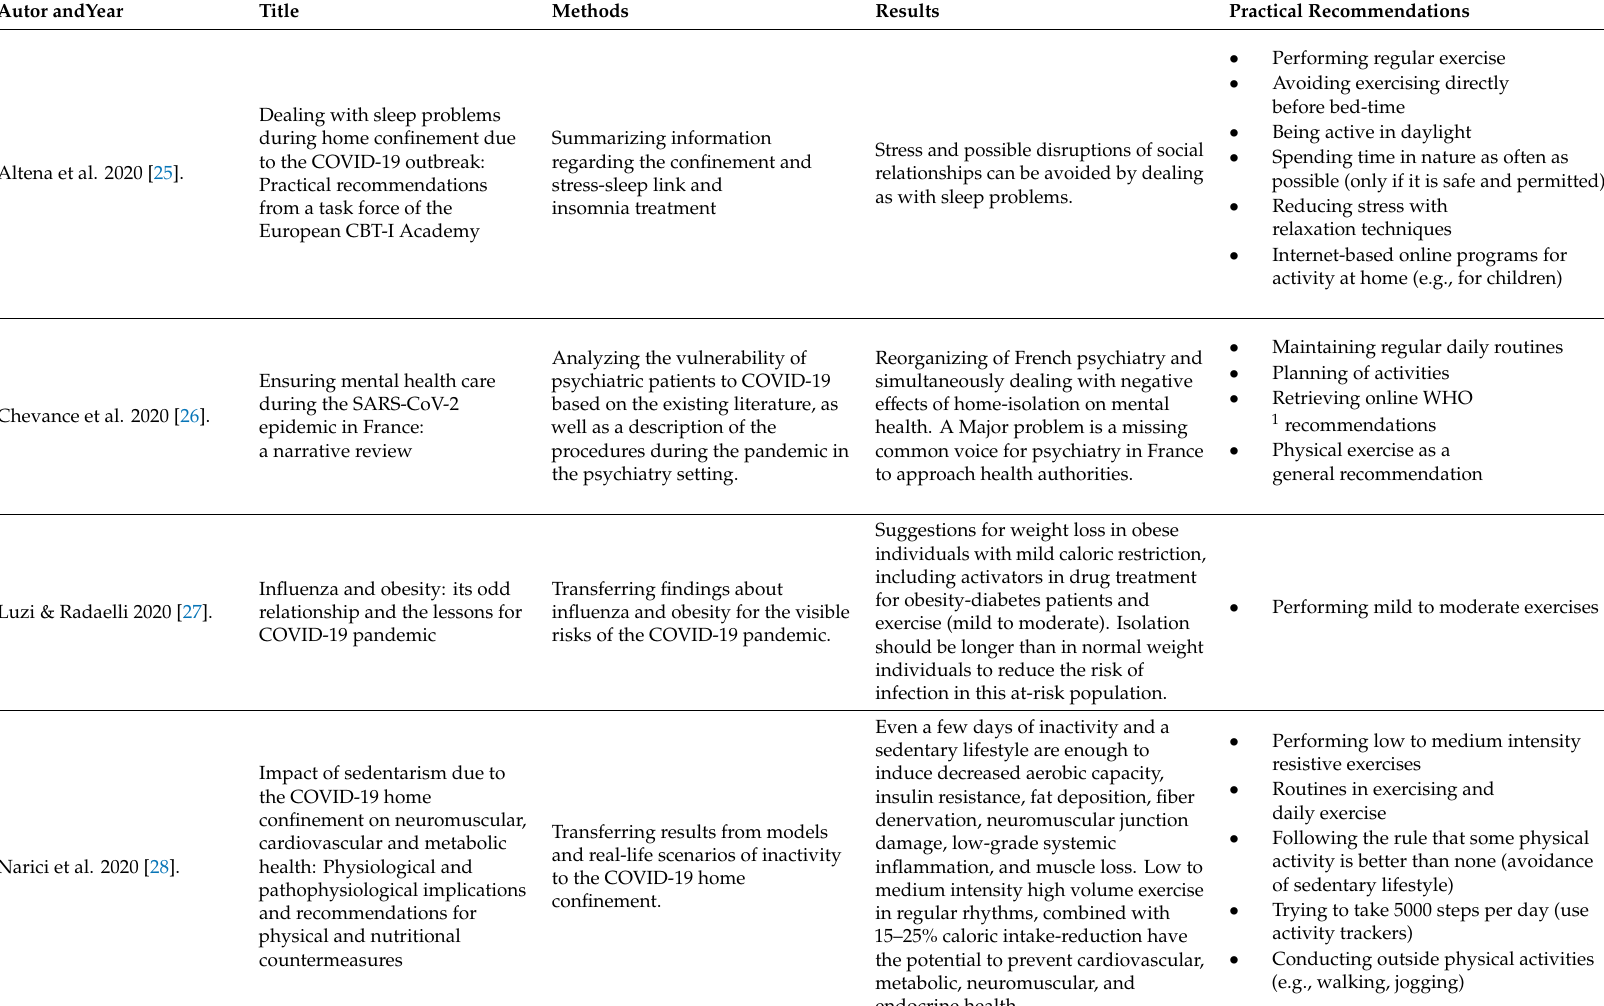
Table 1. Practical Recommendations of studies for “Staying Active” during COVID-19